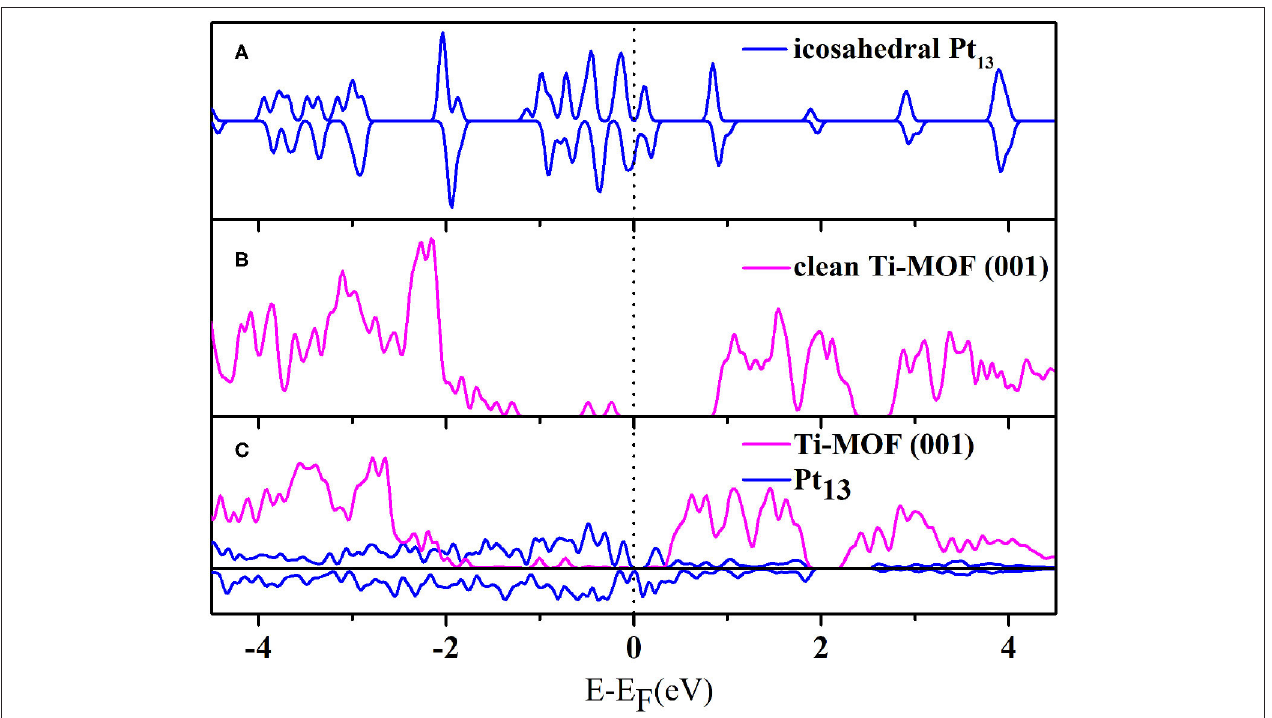
FIGURE 3 | The calculated total density of states (TDOS) for (A) the icosahedron Pt 13 cluster, (B) the clean 20%-MIL-125-(SCH 3 ) 2 (001) surface, and (C) the optimized Pt 13 /20%-MIL-125-(SCH 3 ) 2 system (the Pt 13 cluster is spin-polarized).